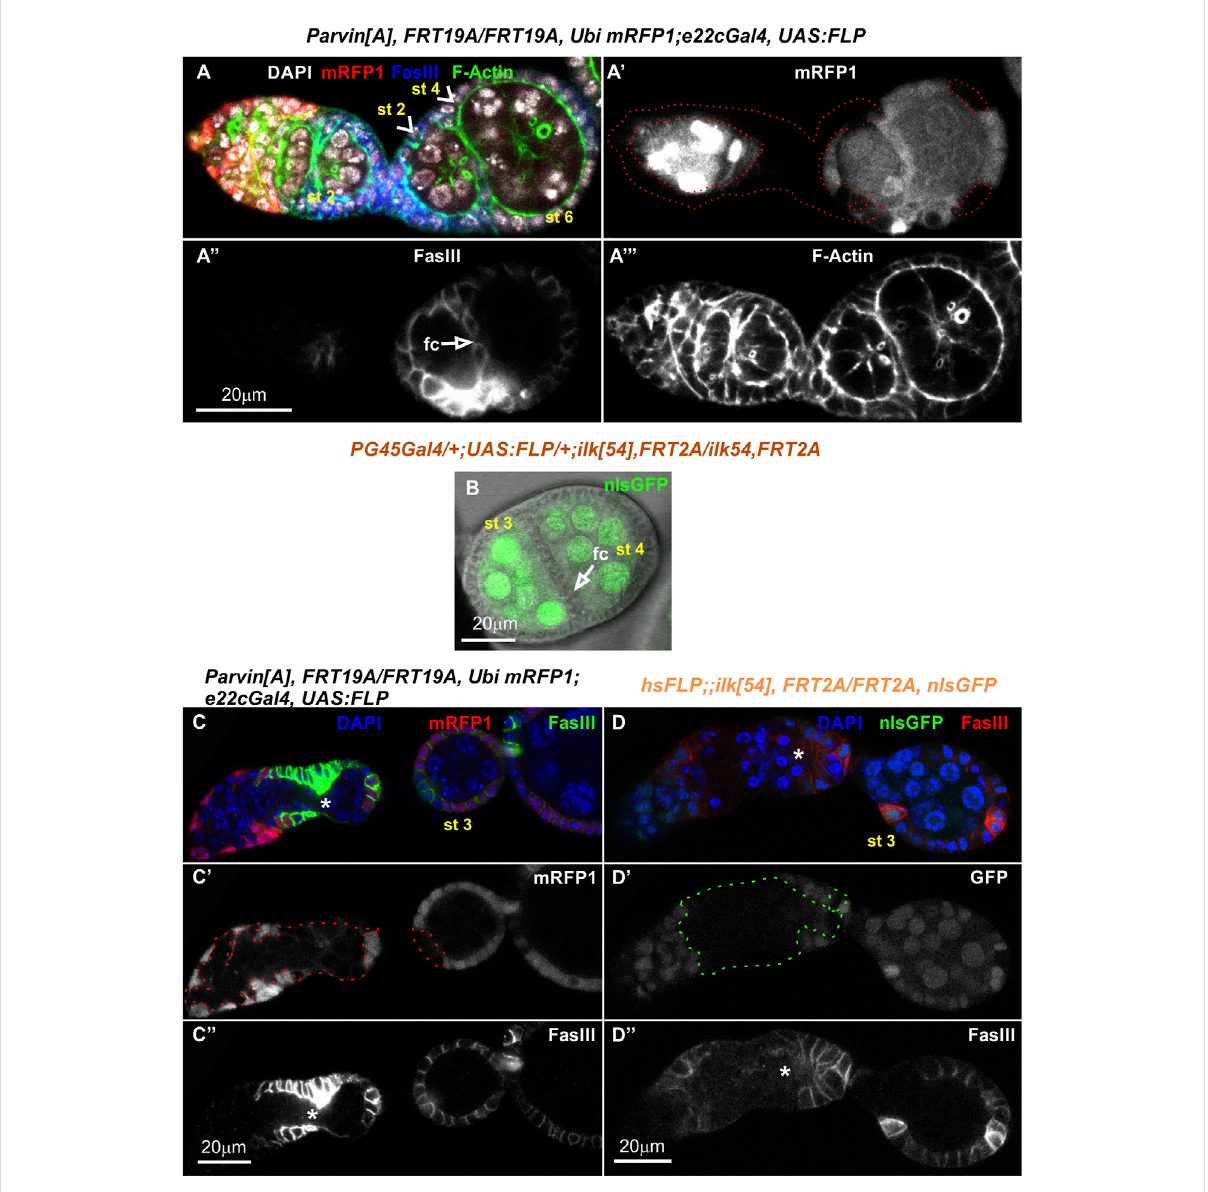
FIGURE 10 Geneticmosaicsfor Parvin and Ilk leadtofusedormalformedeggchambers.Confocalmicrographsofeggchambersderivedfrom (A-A - ,C-C") Parvin A mosaic adult fl y generated by e22cGal4 and (B,D-D") Ilk 54 mosaic adult fl y generated by (B) PG45Gal4 , which starts to express very early in oogenesisinalmosttheentiresomaticepitheliumresultinginverylargemutantclonesorby (D-D") hsFLP ,whichisexpressedinastochasticmanner andlessfrequentlyproduceslargeclones.Fused Parvin mosaiceggchambers(st2-st4)separatedbyamonolayerofepithelialcells.Co-staining with F-actin and FasIII labels the periphery of follicle epithelial cells. (A 9 ,C 9 ) Parvin A mutant cells were marked by the absence of mRFP1 and highlightedwith areddashedline. (B) Mergedconfocal fl uorescenceandphasecontrastmicroscopyimagedepictsfused Ilk eggchambers(st3-st4) separated by a monolayer of epithelial cells. Ilk 54 mutant cells were marked by the absence of nlsGFP . (C,D) No obvious separation between the distinct stages of the germarium in (C-C") Parvin A mutant clone and (D-D") Ilk 54 mutant clone. Asterisks indicate the lack of separation between R2 and R3 in the germarium. fc, follicle cells. Scale bars: 20 μ m in all